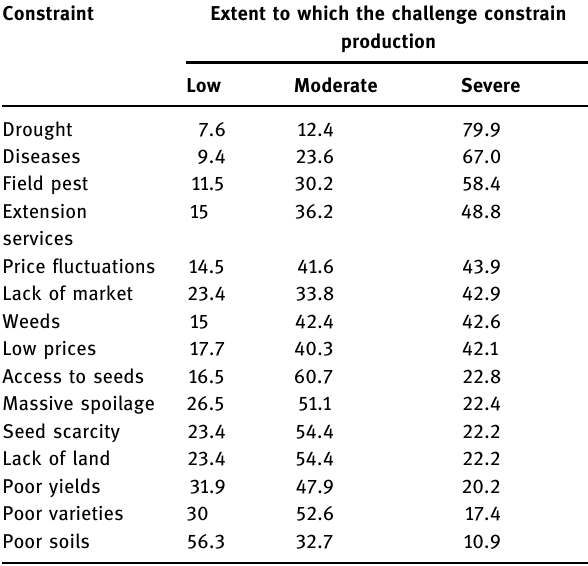
Table 2: Extent to which the challenge constrained the utilization